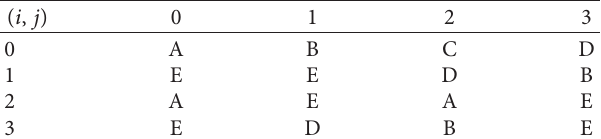
Table 1: p ≢ q ( mod 8 ) .